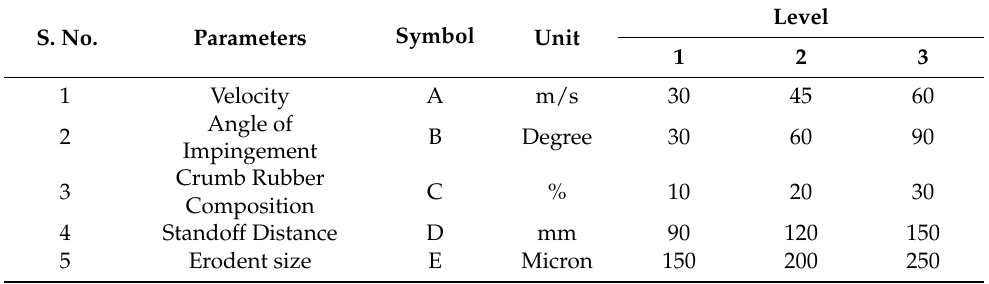
Table 1. Erosion parameters and their levels. S.